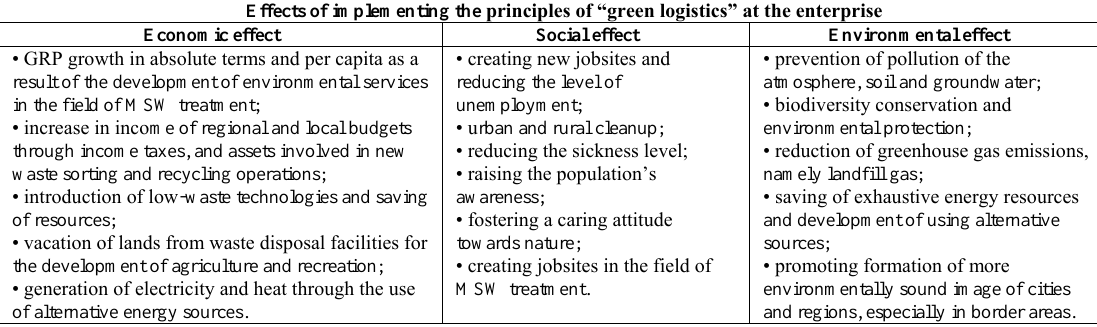
Table 8. Qualitative assessment of the effectiveness from implementing the principles of “green logistics”. Effects of implementing the principles of “green logistics” at the enterprise Economic